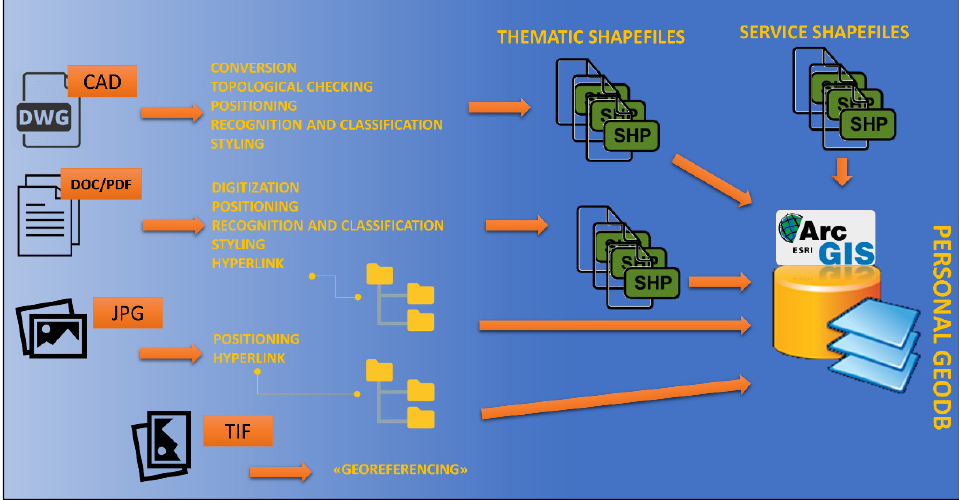
Figure 3. Conceptual scheme of the database implemented within a personal